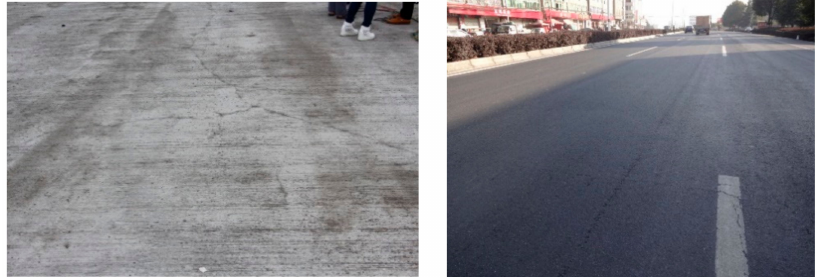
Figure 4. Irregular cracks in the CRCP ( left ) and transverse reflection crack in the asphalt layer ( right ).